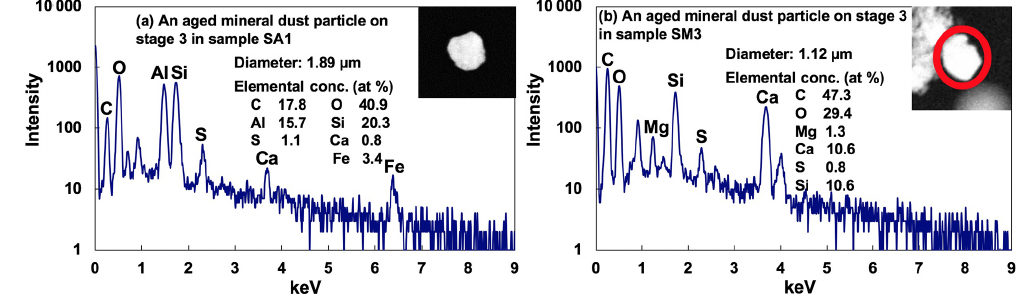
Figure 8. SEIs, X-ray spectra, and element atomic concentrations of aged mineral dust